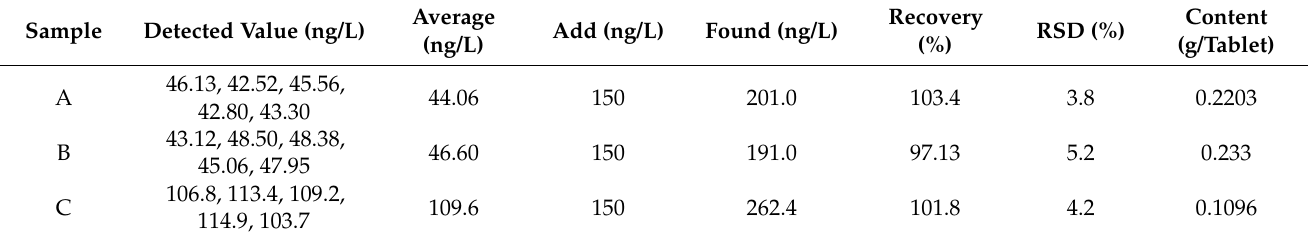
Table 2. RRS results of water